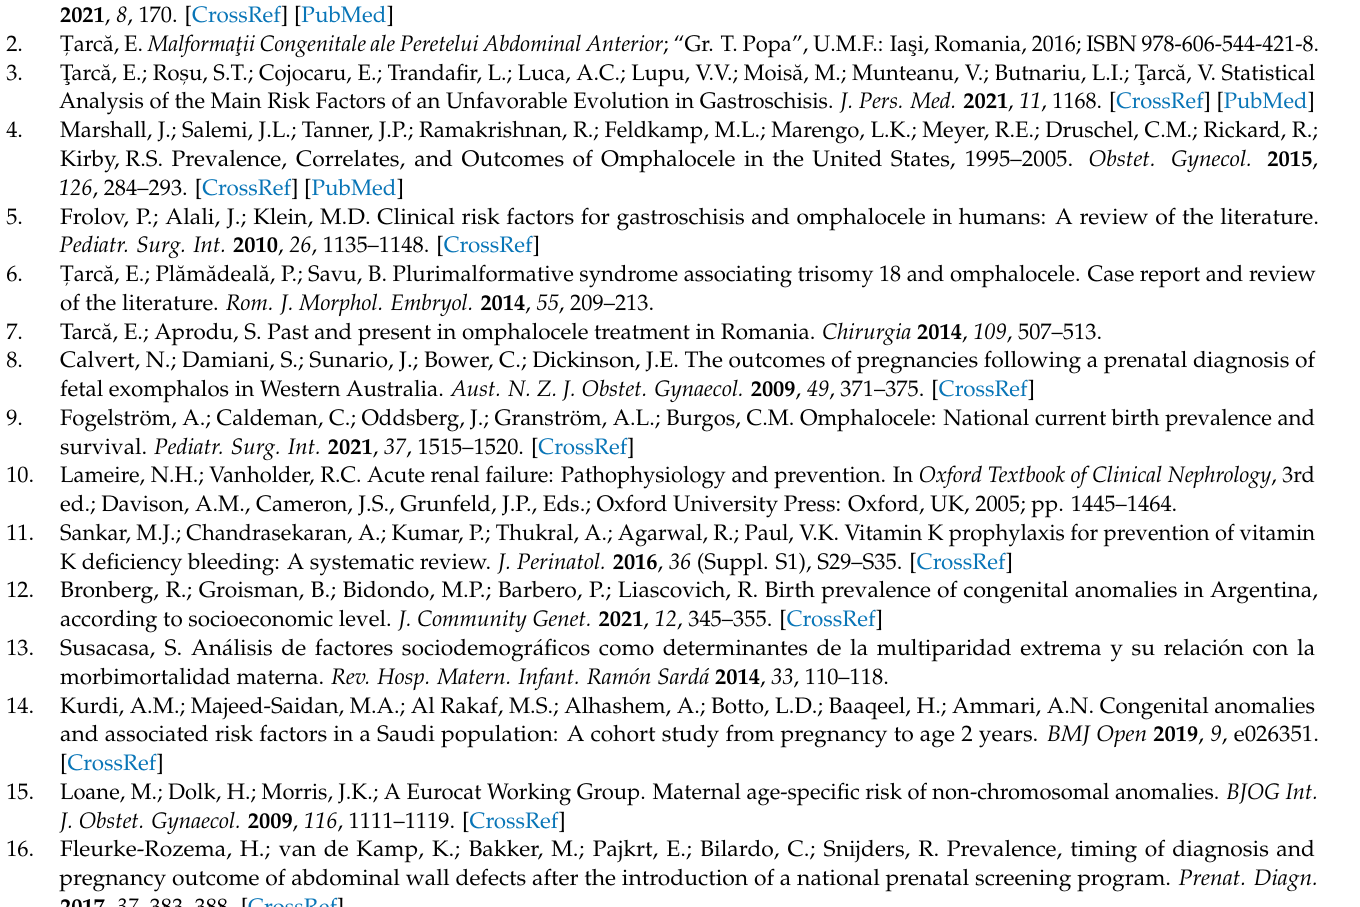
Table S2. Model summary. Table S3. Variables in the Equation. Table S4. Confusion matrix. Table S5. Collinearity